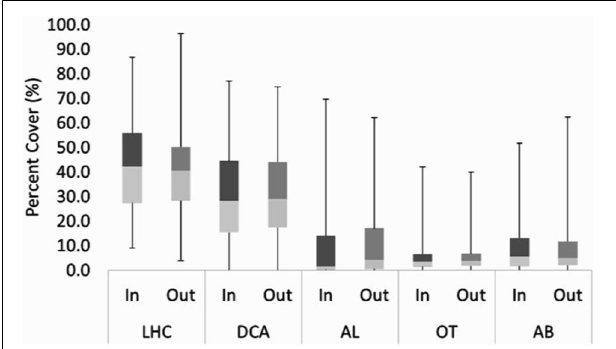
FIGURE 2 | Mean benthic cover inside and outside all MPAs